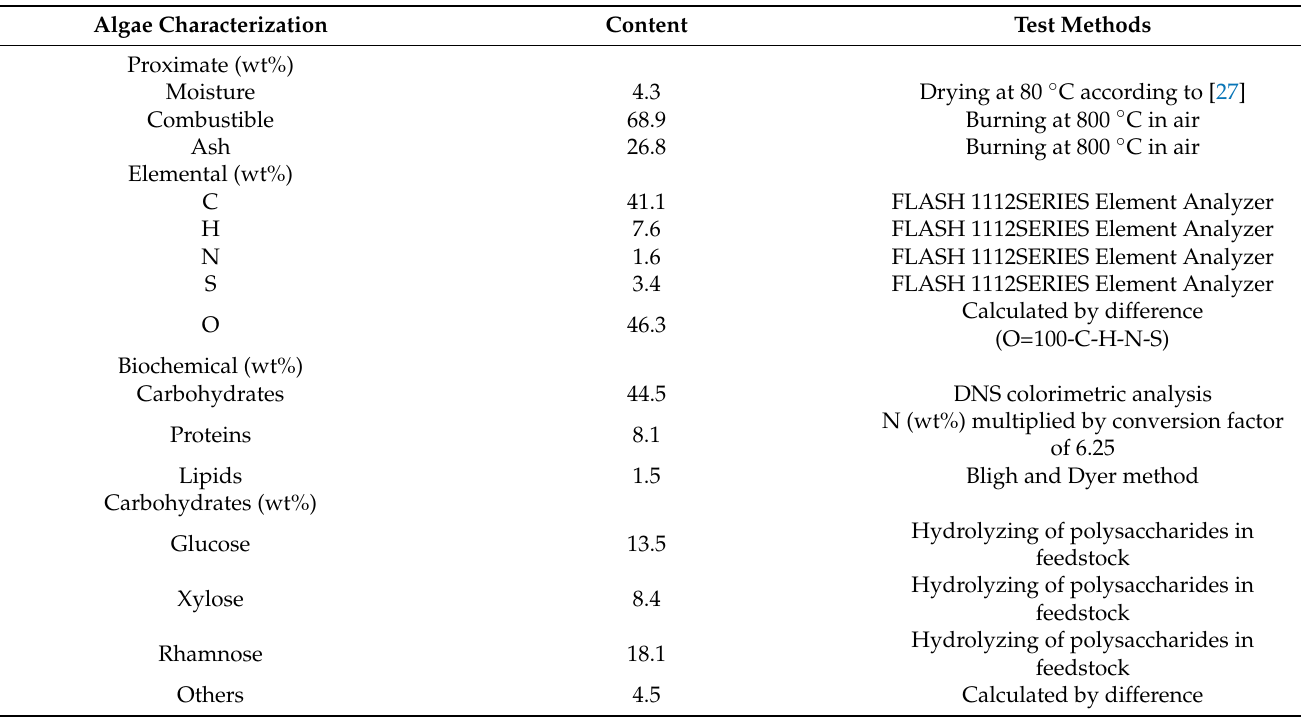
Table 1. The composition of Ulva